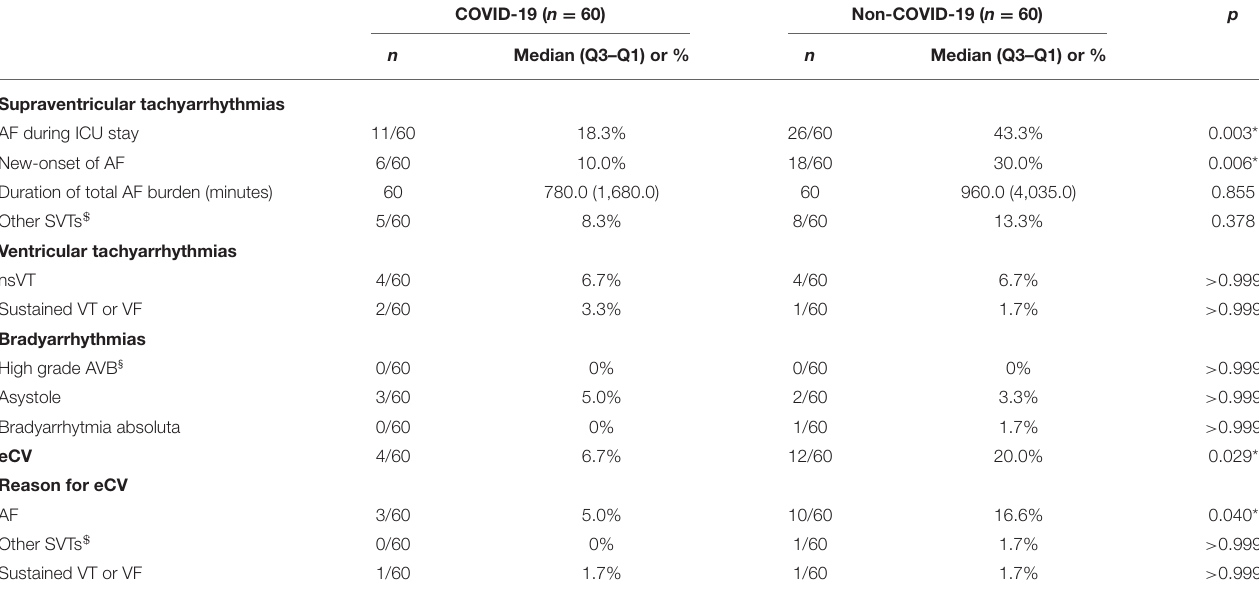
TABLE 2 | Continuous rhythm monitoring during ICU